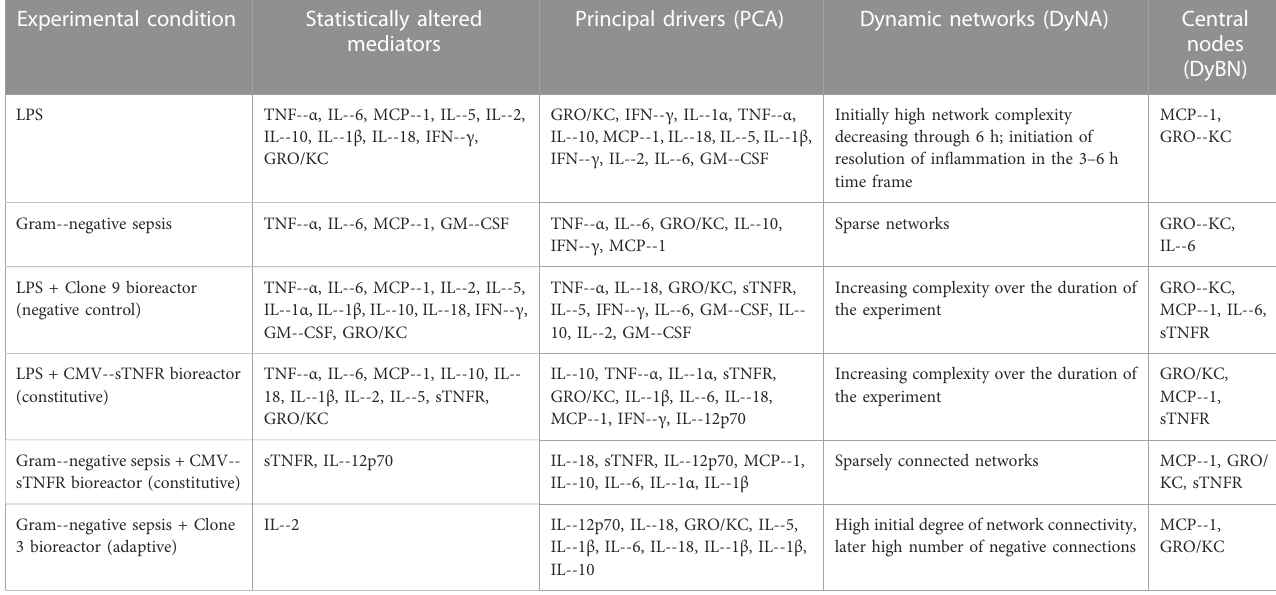
TABLE 1 Summary of key results inferred from the six experimental conditions. One--way ANOVA was used to de fi ne the in fl ammatory mediators that were altered signi fi cantly over time. Principal component analysis (PCA) was used to de fi ne principal characteristics of the systemic in fl ammatory response in each experimental condition. Dynamic network analysis (DyNA) was used to visualize the dynamic progression of systemic in fl ammatory networks in each experimental group. Dynamic Bayesian network (DyBN) inference was used to suggest the most likely feedback structures that could de fi ne central nodes. Experimental